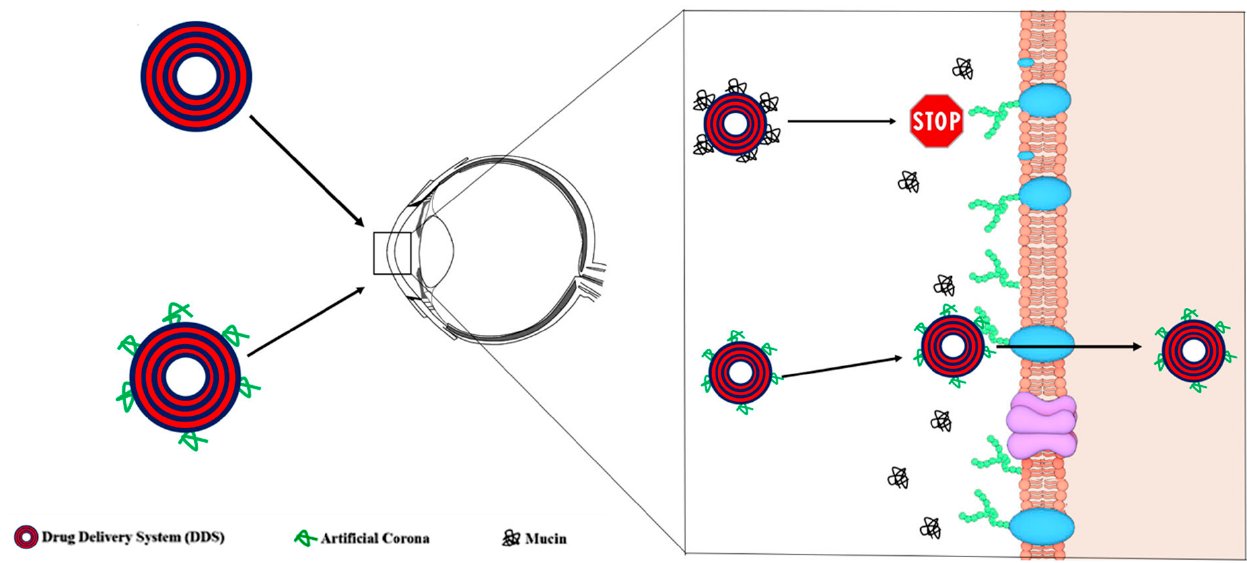
Figure 4. Upon topical eye administration drug delivery systems are coated by mucins that inhibit association with corneal epithelial cells. On the other side, artificial coronas with affinity for cell receptors promote massive internalization by a receptor-mediated mechanism.